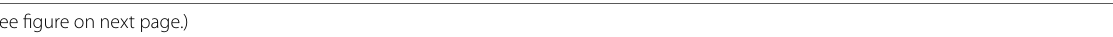
figure on next Fig. 19 Lower molars of Protadelomys lugdunensis Hartenberger, 1969, from Lissieu (Rhône), a LIS 67, right m1; a1, occlusal view; a2, buccal aspect. b LIS 55, right m1; b1, occlusal view; b2, buccal aspect; b3, lingual aspect. c : LIS 53, left m1; c1, occlusal view; c2 buccal aspect; c3, lingual aspect. d LIS 66, left m1?; d1, occlusal view; d2, buccal aspect; d3, lingual aspect. e LIS 56, left m1 or m2, occlusal view. f LIS 59, left m2; f1, occlusal view; f2, buccal aspect; f3, lingual aspect. g LIS 42, left m2, occlusal view. h LIS 69, left m2; h1, occlusal view; h2, buccal aspect; h3, lingual aspect. i : LIS 57, left m2, occlusal view. j : LIS 36, left m3; j1, occlusal view; j2, buccal aspect; j3, lingual aspect. k : LIS 29, right m3; k1, occlusal view; k2, buccal aspect; k3, lingual aspect. l : LIS 39, left m3; l1, occlusal view; l2, lingual aspect; l3, buccal aspect. Scale bar 1 =